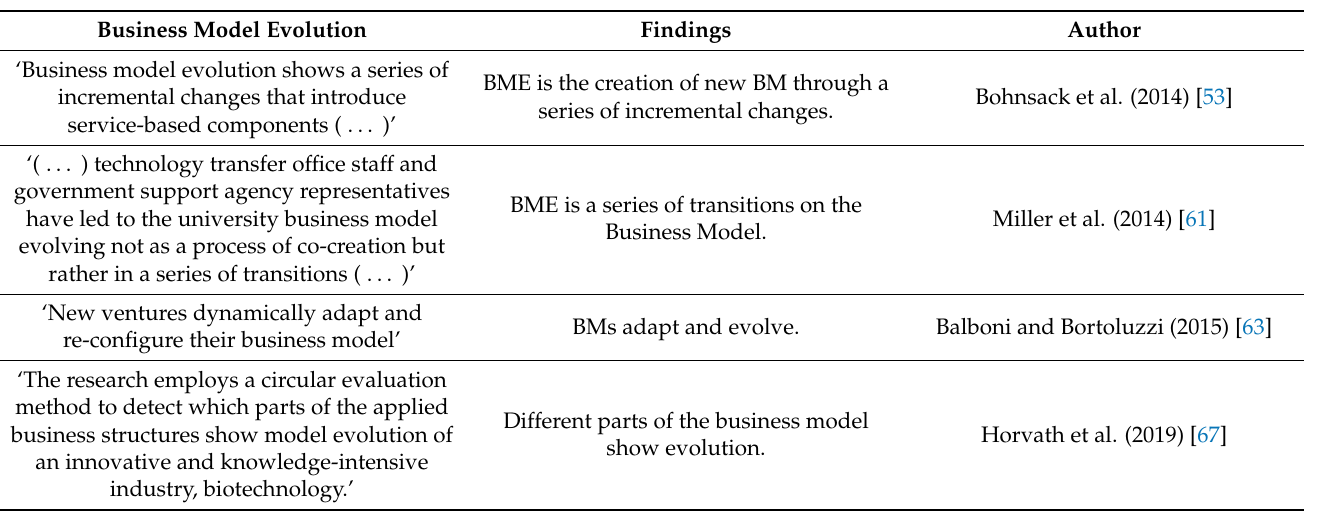
Table 5. Authors that define Business Model Evolution.